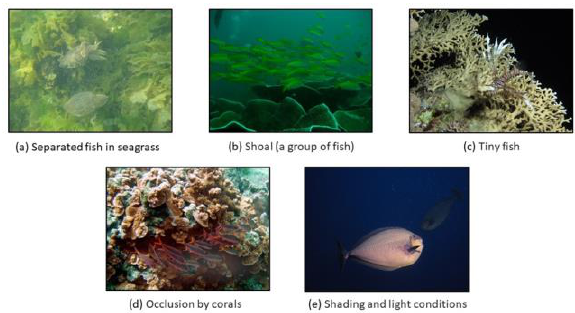
Figure 2 . Fish samples with different